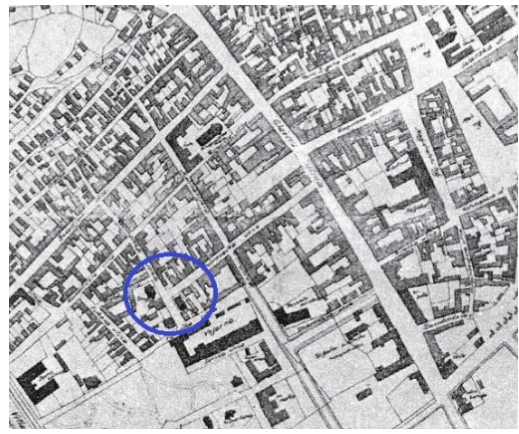
Figure 13. Jewish quarter of Zemun in 1909.